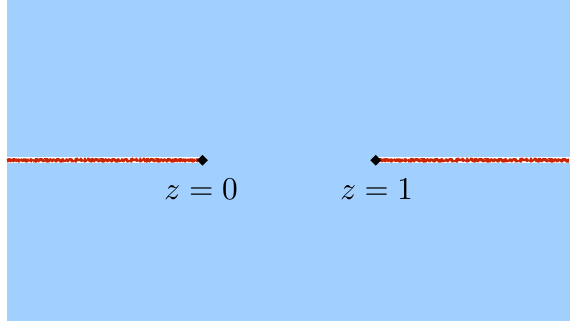
Figure 1 . The physical region where the 1D crossing equation holds is z 2 (0 ; 1). Allowing complex z shows the full domain of validity of the equation is the entire blue region R (cid:17) C n (( (cid:0)1 ; 0] [ [1 ; 1 )). The equation stops holding after an analytic continuation from this region through one of the branch